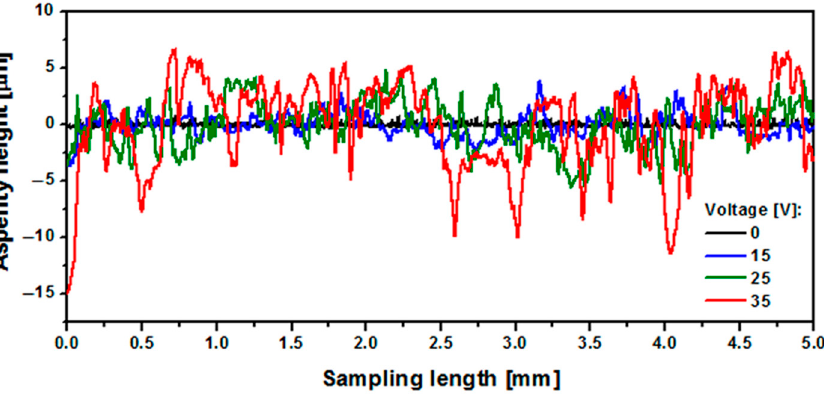
Figure 11. Roughness profile for the Ti-13Zr-13Nb alloy surface before and after anodizing at 15–35 V. Basic surface texture parameters for the Ti-13Zr-13Nb alloy surface as a function of anodizing voltage are presented in Figure 12.